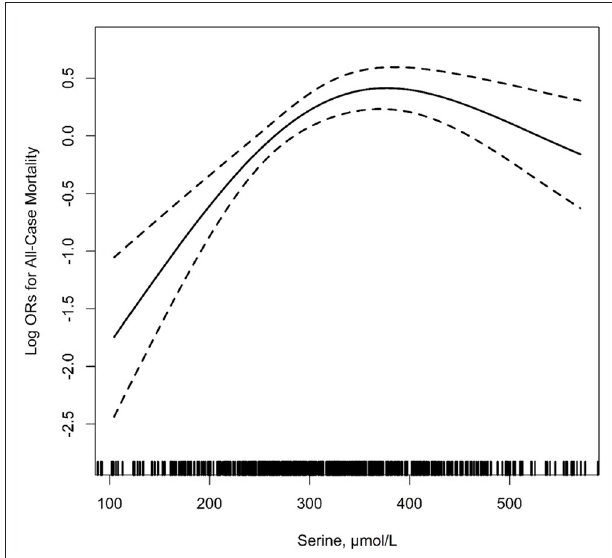
FIGURE 2 | The relationship of serum serine with the risk of all-cause mortality 1 . 1 Adjusted for age, sex, body mass index (BMI), treatment group, MTHFR C677T genotypes, smoking, alcohol drinking, systolic blood pressure (SBP), diastolic blood pressure (DBP), fasting blood glucose, total cholesterol (TC), triglycerides (TG), high-density lipoprotein cholesterol (HDL-C), estimated glomerular filtration rate (eGFR) at baseline, folate, total homocysteine (tHcy), vitamin B12 as well as mean SBP and DBP during the treatment period.